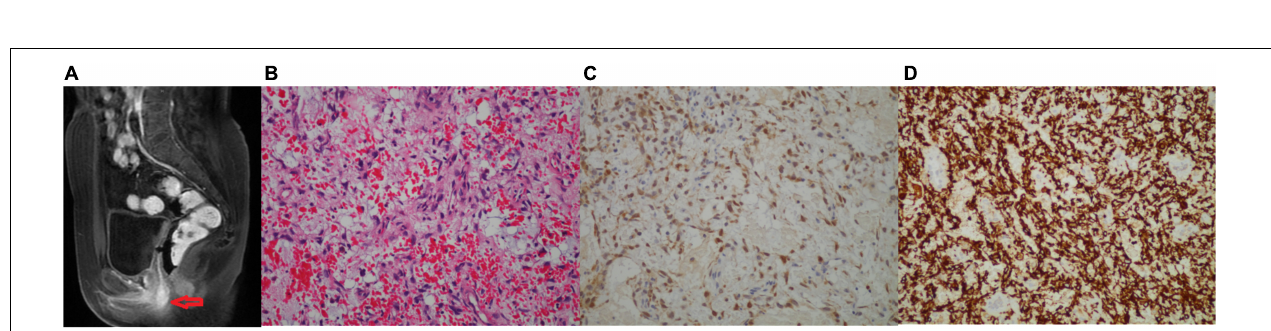
FIGURE 3 | (A–D) Images of the vagina tumor. (A) The pelvic MRI (sagittal T1-weighted images with contrast) showing homogenous enhancement from the posterior vagina to the vulva with approximately 1.5 × 1.6 cm, which was considered tumor recurrence. (B) H&E-stained (200 × ): the tumor tissue is composed of predominantly monomorphic spindled cells arranged in bundles, sheets, or zigzag. The nuclei are oval, chromatin vacuolated, nucleoli are not evident, mitosis is easy to see, and no necrosis. (C) IHC of S-100 (200 × ) was positive. (D) IHC of Pan-TRK (200 × ) was strongly positive.